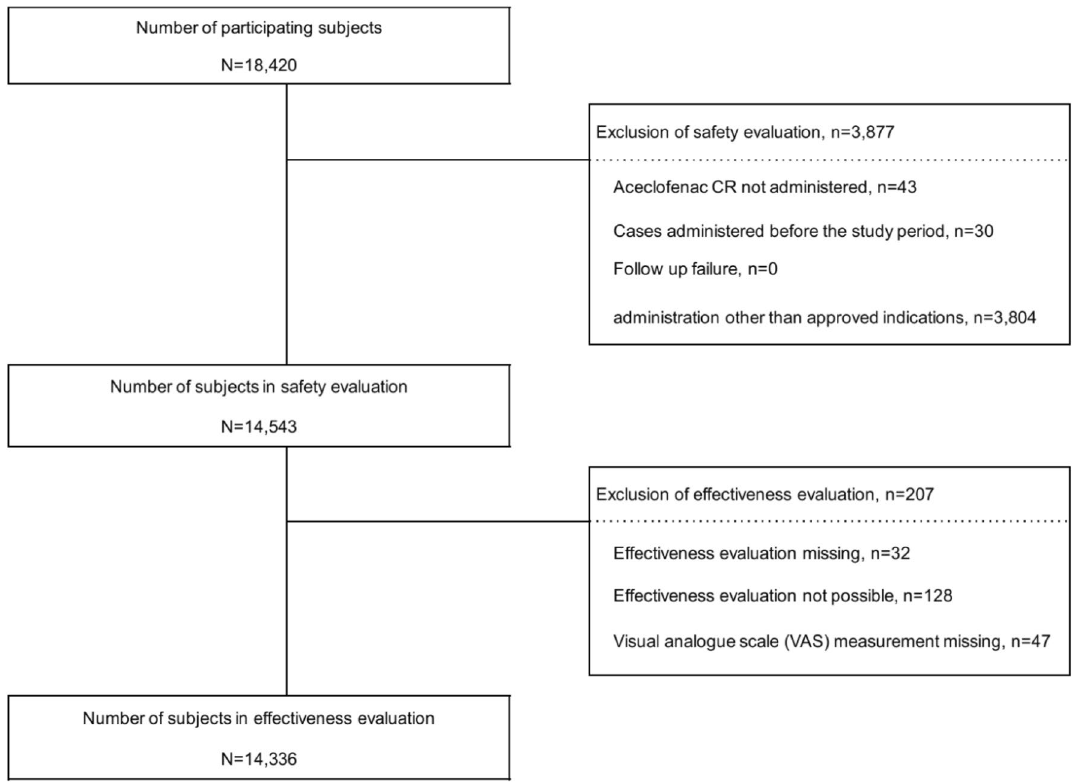
Figure 1. Participation status of the study